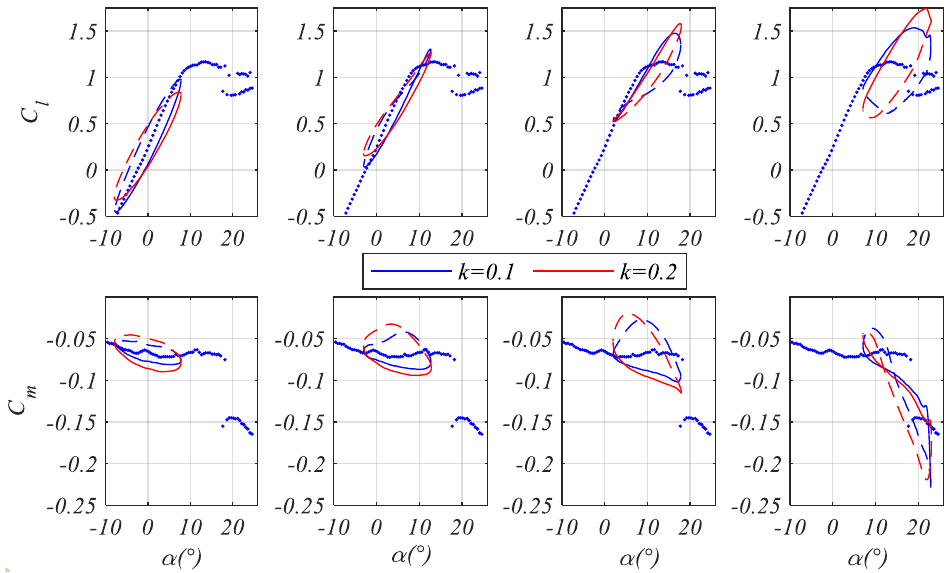
Figure 16. Lift and moment coefficients for reduced frequency k = 0.1 (blue loops) and k = 0.2 (red loops).